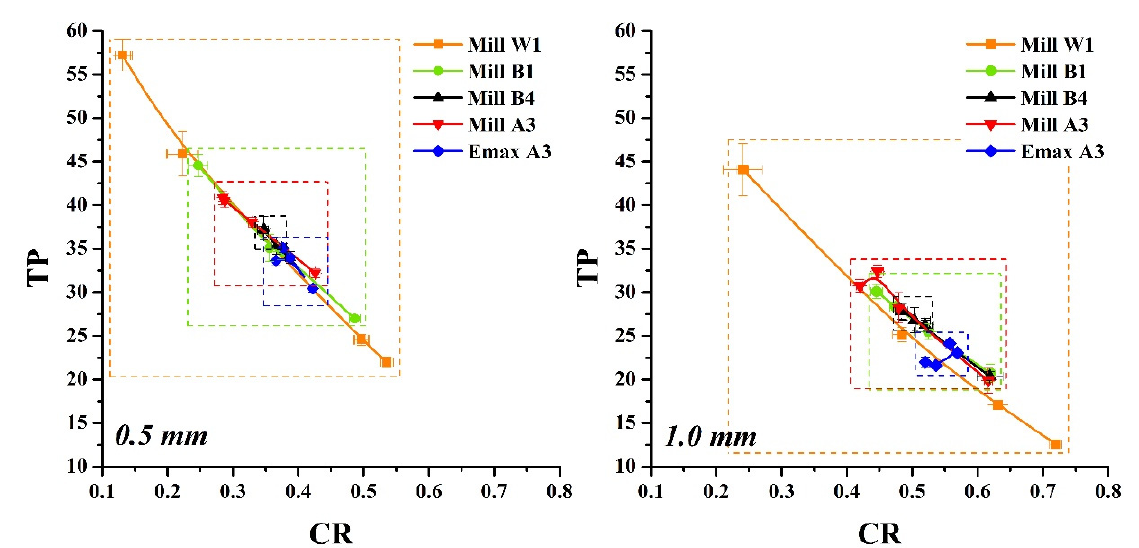
Figure 4. Correlation between translucency parameter and contrast ratio of dental glass-ceramic systems.